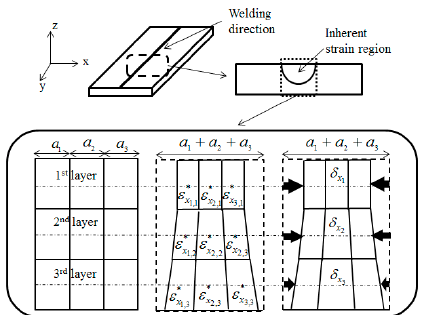
Figure 1. Inherent strain concept and inherent deformation due to element plastic strain